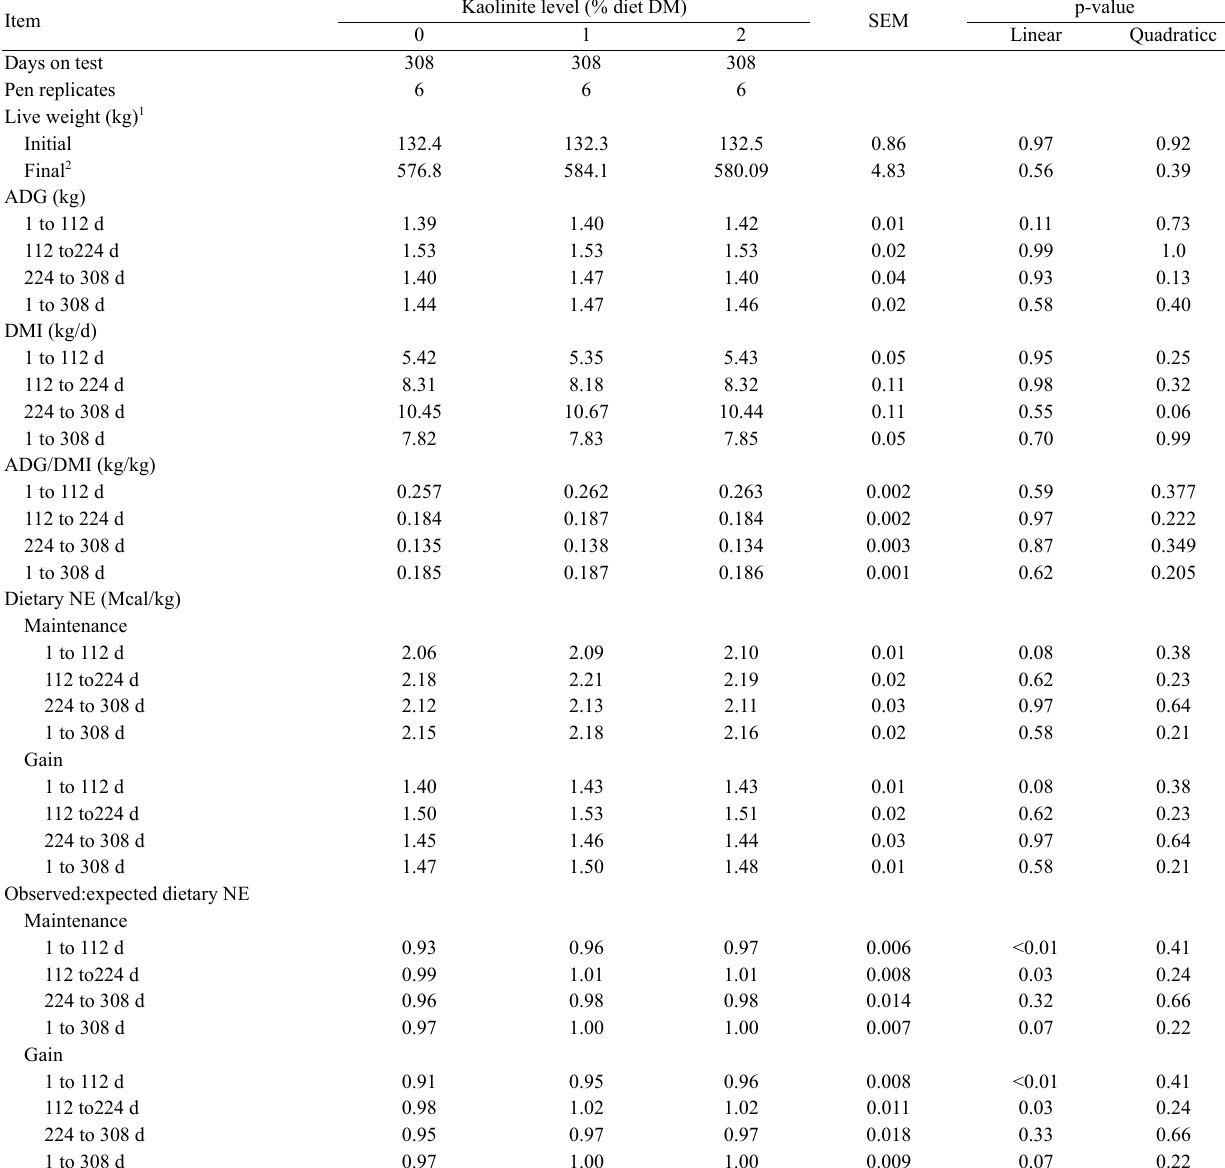
Table 4. Influence of supplementation level of kaolinite clay on growth performance of feedlot